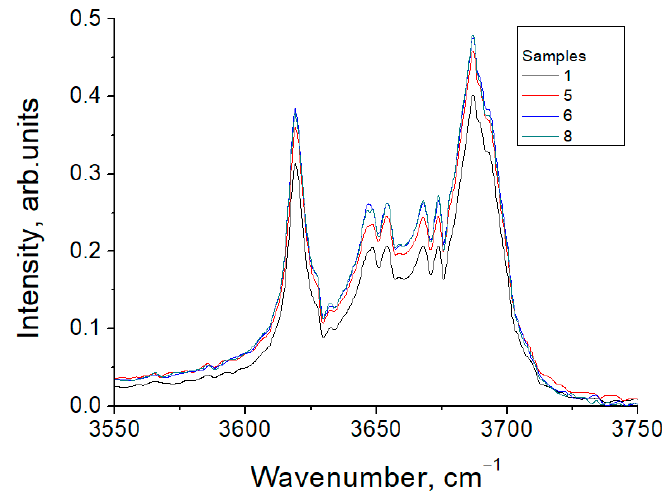
Figure 5. Regions of the IR spectra of dried samples 1, 5, 6, and 8.